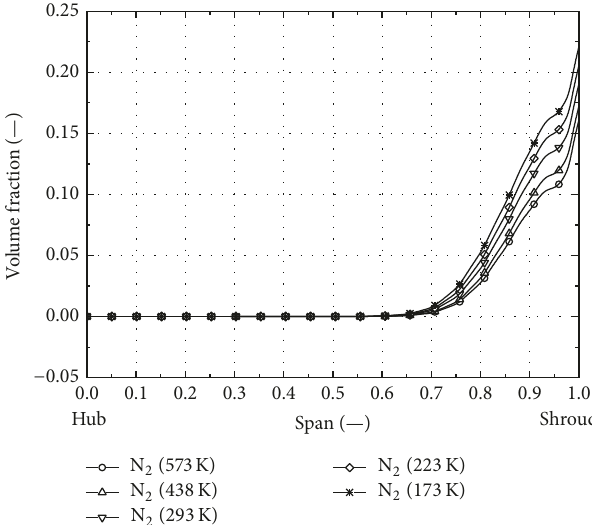
Figure 25: Volume fraction obtained from the meridional surface of different